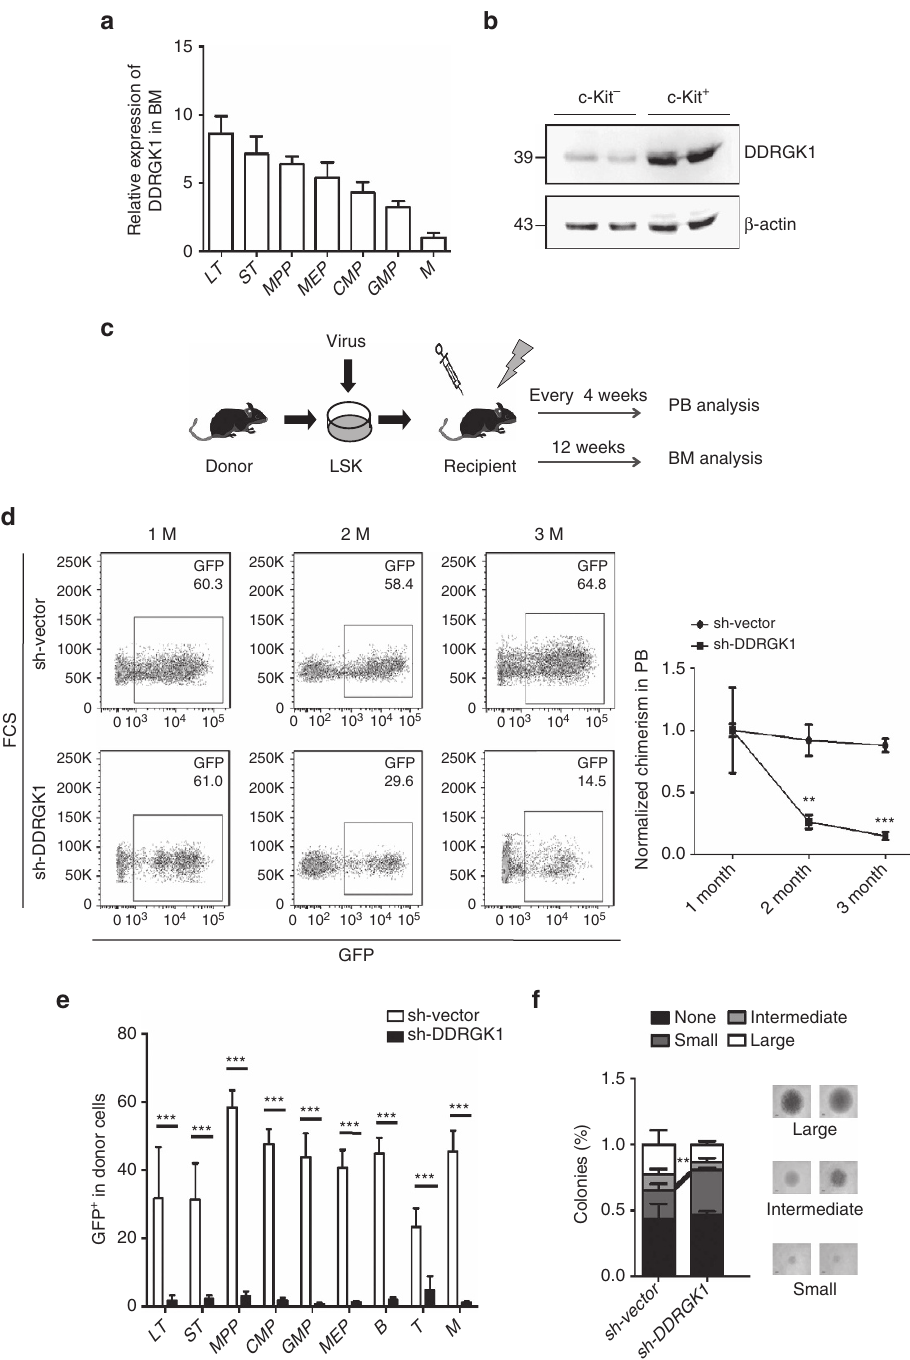
Figure 7 | Knockdown of DDRGK1 impairs the reconstitution ability of murine HSCs. ( a ) Q-PCR analysis of the relative mRNA expression levels of DDRGK1 in the indicated subpopulations of BM from young wild-type mice (2 months old, n ¼ 3). The relative expression of DDRGK1 was normalized to GAPDH. Data are presented as mean ± s.d. ( b ) Western blot analysis of DDRGK1 in enriched Lineage þ c-Kit (cid:2) and Lineage - c-Kit þ cells from young wild-type mice (2 months old). ( c ) Experimental schematic for the reconstitution assay. ( d ) Representative FACS pattern showing the percentage of GFP-positive cells in donor-derived control (sh-Vector) or DDRGK1-knockdown (sh-DDRGK1) PB cells (Left panel). The values represent the normalized percentages of donor-derived GFP þ cells in the total engraftment (Right panel, n ¼ 3). Data are presented as mean ± s.d. ** P o 0.01 and *** P o 0.001 by Student’s t -test. ( e ) The values represent the percentages of donor-derived GFP þ cells in LT-HSC (CD34 - Flt3 - LSK), ST-HSC (CD34 þ Flt3 - LSK), MPP (CD34 þ Flt3 þ LSK), CMP (CD34 þ CD16/32 - Sca1 - c-Kit þ Lin (cid:2) ), GMP (CD34 þ CD16/32 þ Sca1 - c-Kit þ Lin (cid:2) ), MEP (CD34 - CD16/32 - Sca1 - c-Kit þ Lin (cid:2) ), B, T and myeloid lineage cell populations in the BM from primary recipient mice 12 weeks after transplantation ( n ¼ 3). Data are presented as mean ± s.d. *** P o 0.001 by Student’s t -test. ( f ) Single donor-derived GFP þ LT-HSCs from recipient mice were sorted into 96-well plates and cultured for 14 days in vitro . The percentage of colonies was calculated by dividing the number of colonies by the original number of single cells that were seeded. Data are presented as mean ± s.d. ** P o 0.01 by Student’s t